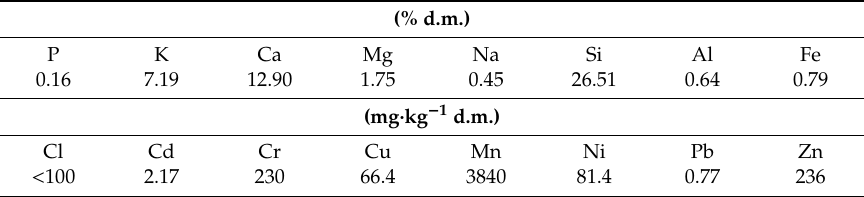
Table 5. Chemical composition of ash obtained from biomass pellets. (%